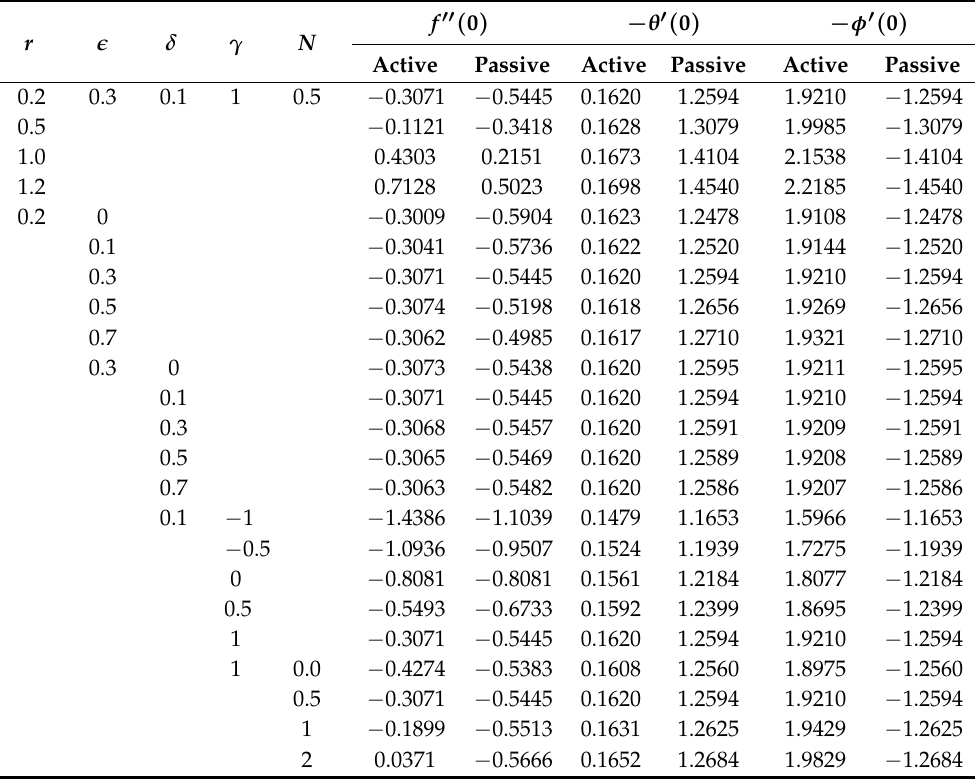
Table 2. Values of f (cid:48)(cid:48) ( 0 ) , − θ (cid:48) ( 0 ) , and − φ (cid:48) ( 0 ) for parameters r , (cid:101) , δ , γ and N under active and passive controls.